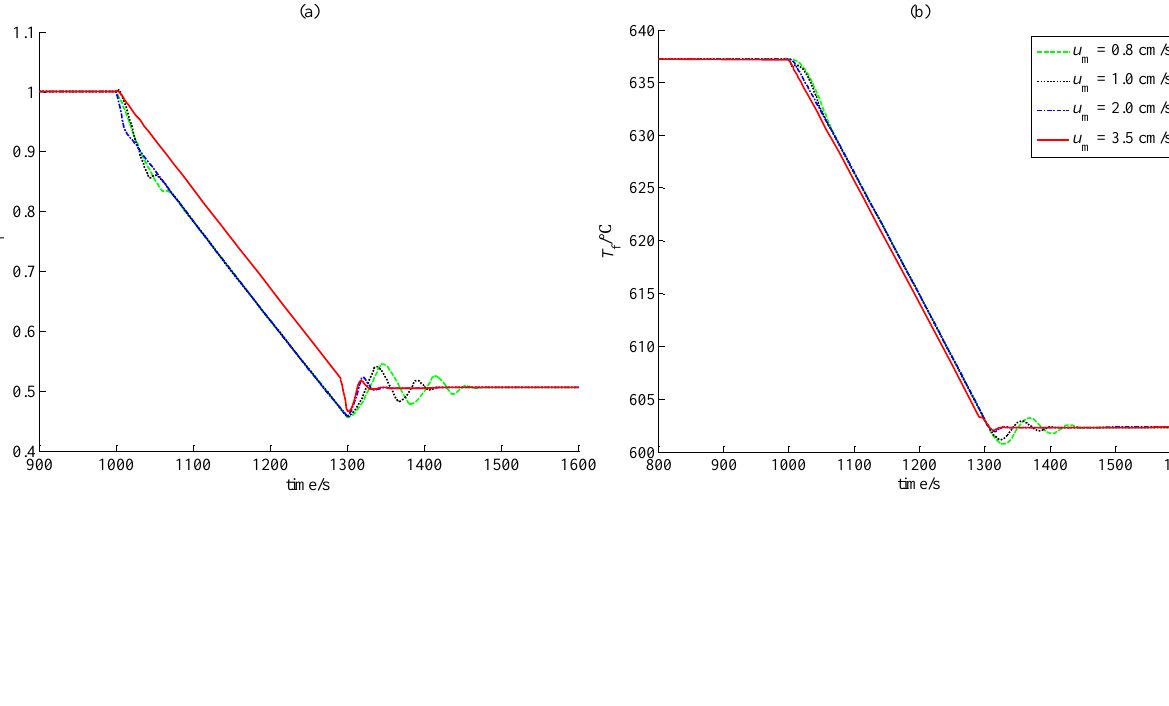
Figure 5. Simulation results in case B: ( a ) relative nuclear power n r ; ( b ) average fuel temperature T f ; ( c ) outlet helium temperature T cout ; ( d ) error signal e ξ between ξ and ξ d ; ( e ) designed control rod speed signal u and ( f ) compensating signal u